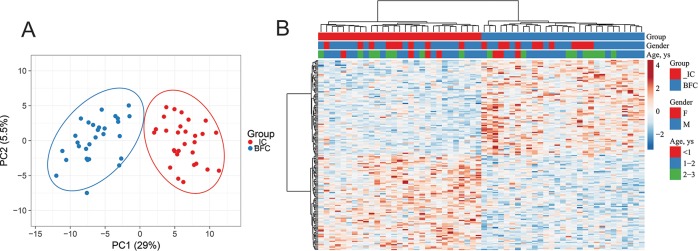
Principal component plot (A) and heatmap (B) demonstrating the clustering of IC and BFC children (columns) based on the methylation levels (beta-values) of the 164 DMESs (rows). The top tracks of the heatmap show individual's group status and demographics.